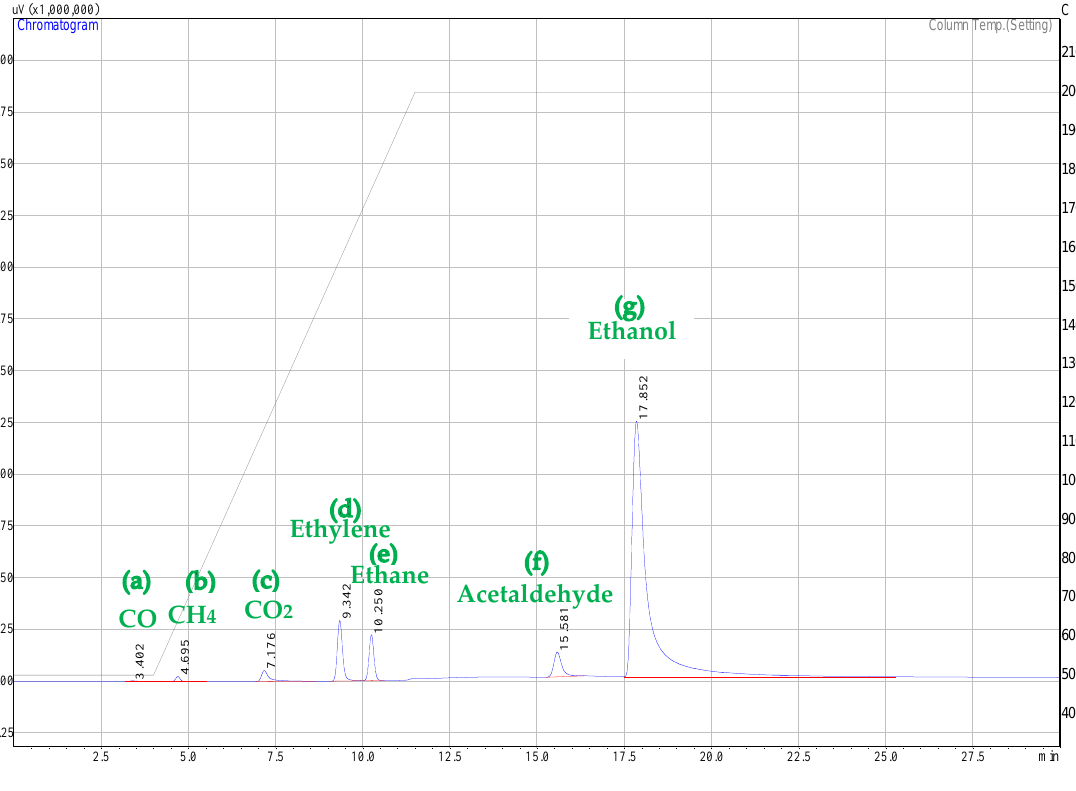
Figure A3. Carbon containing product species peaks as detected by the FID for: (a) carbon monoxide (CO); (b) methane (CH 4 ); (c) carbon dioxide (CO 2 ); (d) ethylene (C 2 H 4 ); (e) ethane (C 2 H 6 ); (f) acetaldehyde (C 2 H 4 O); and (g) ethanol (C 2 H 5 OH). The H 2 gas chromatographic peaks were quantified using the TCD calibration, as reported in Figure A4. Calibration was established by using an H 2 certified standard gas mixture sample (10% H 2 and 90% He Praxair) and different hydrogen volumes (0.1, 0.2,